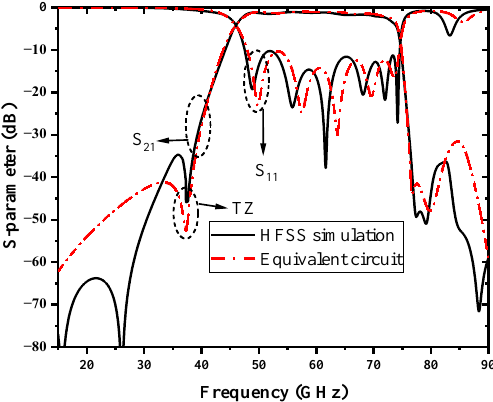
Figure 10. Comparison of equivalent circuit and filter simulations.